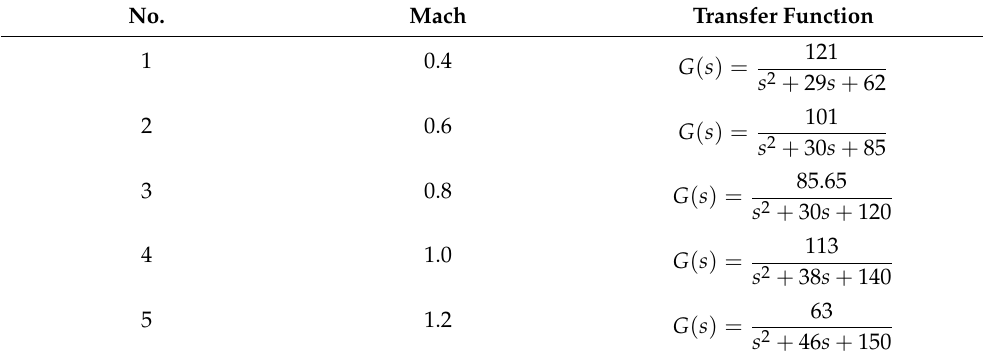
Table 1. Models of the Multi-mode Wind Tunnel Field.